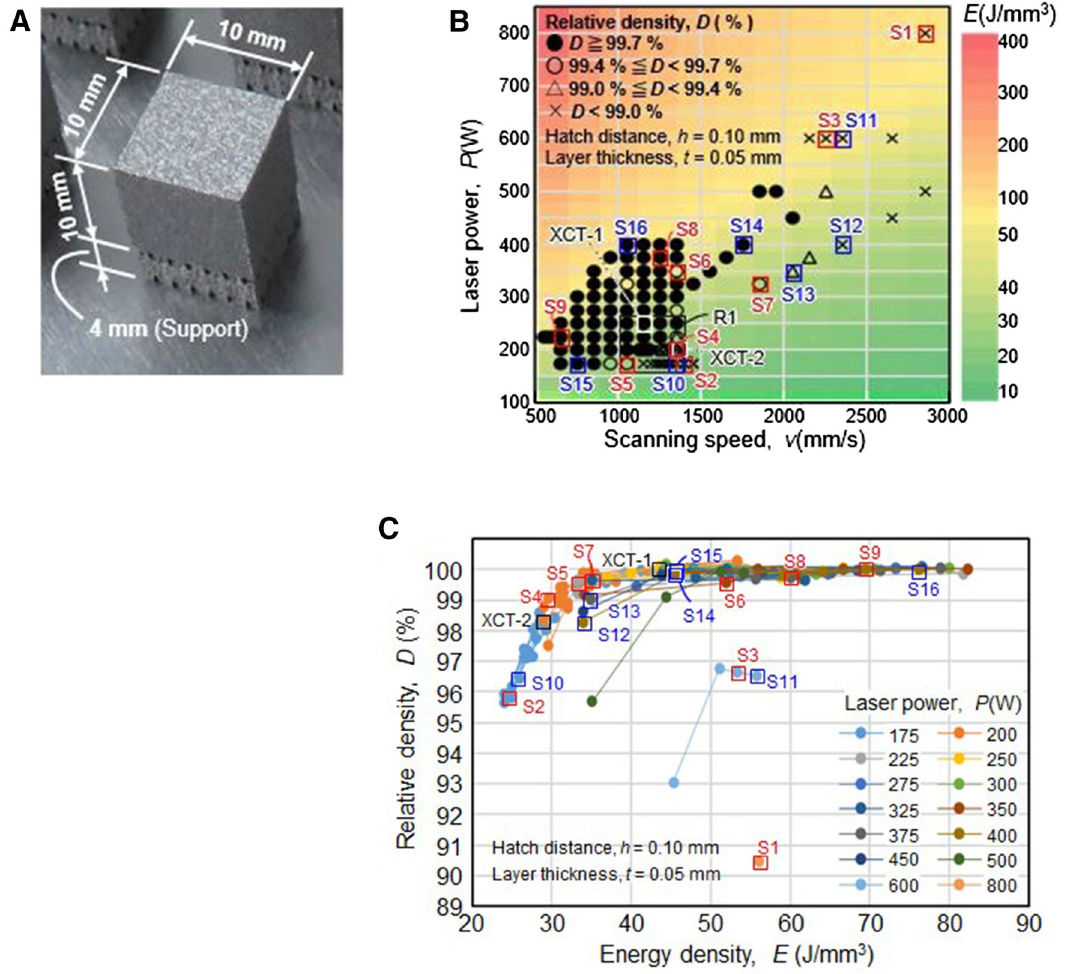
Figure 1. Relationship evaluated by the relative density between process parameters and density, ( A ) cubic specimen; ( B ) process map between laser power and scan speed; ( C ) relationship between relative density and energy density. Images created using Microsoft Office Excel 2019 (https:// www. micro soft. com/ ja- jp/ micro soft- 365/